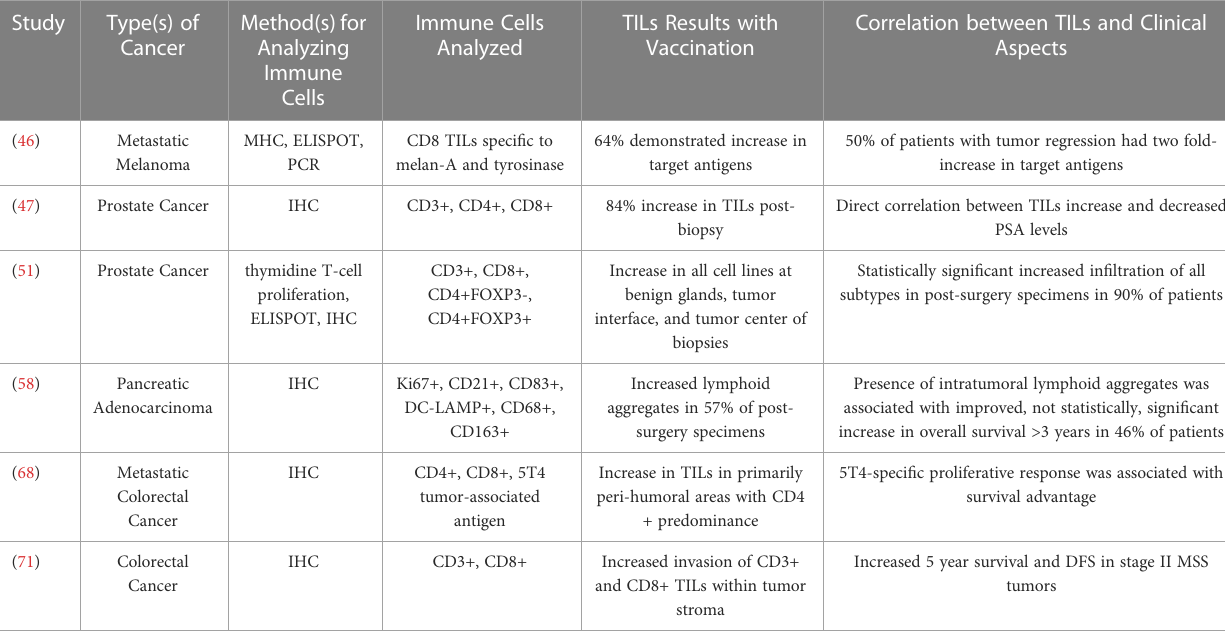
TABLE 1 Previously studied TILs response measure in cancer vaccine